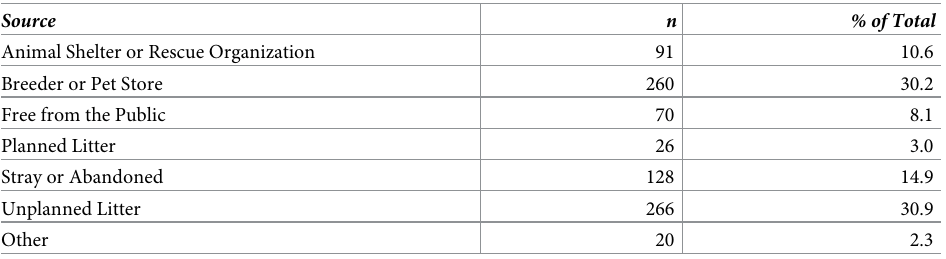
Table 4. Sources of rats reported by relinquishing owners (N =